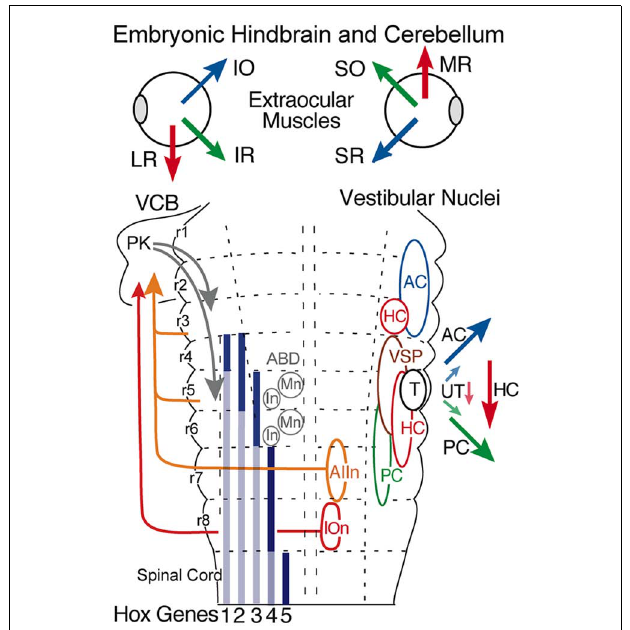
FIGURE 3 | Hindbrain segmental organization of vestibular nuclei with schematic diagram of canal and otolith-specific vestibuloocular behaviors and hox gene expression. Corresponding color-coded arrows and excitatory vestibuloocular subgroups in r1-3 and r5-7 indicate the close spatial alignment between canal planes and vertical, oblique, and horizontal extraocular muscle pulling directions. Afferents from the inferior olive (r8) and vestibular subgroups (r3, r5, r7) to the vestibulocerebellum (VCB) are necessary for vestibuloocular reflex plasticity. Adapted from Straka etal. (2001). ABD, abducens nucleus; AC, PC, HC, anterior vertical, posterior vertical, horizontal canal; In, internuclear neuron; IOn, inferior olivary neurons; IO, SO, inferior, superior oblique; IR, LR, MR, SR, inferior, lateral, medial, superior rectus; Mn, motoneuron; PK, Purkinje cell;T, tangential nucleus; UT, utricle;VSP, vestibulospinal.